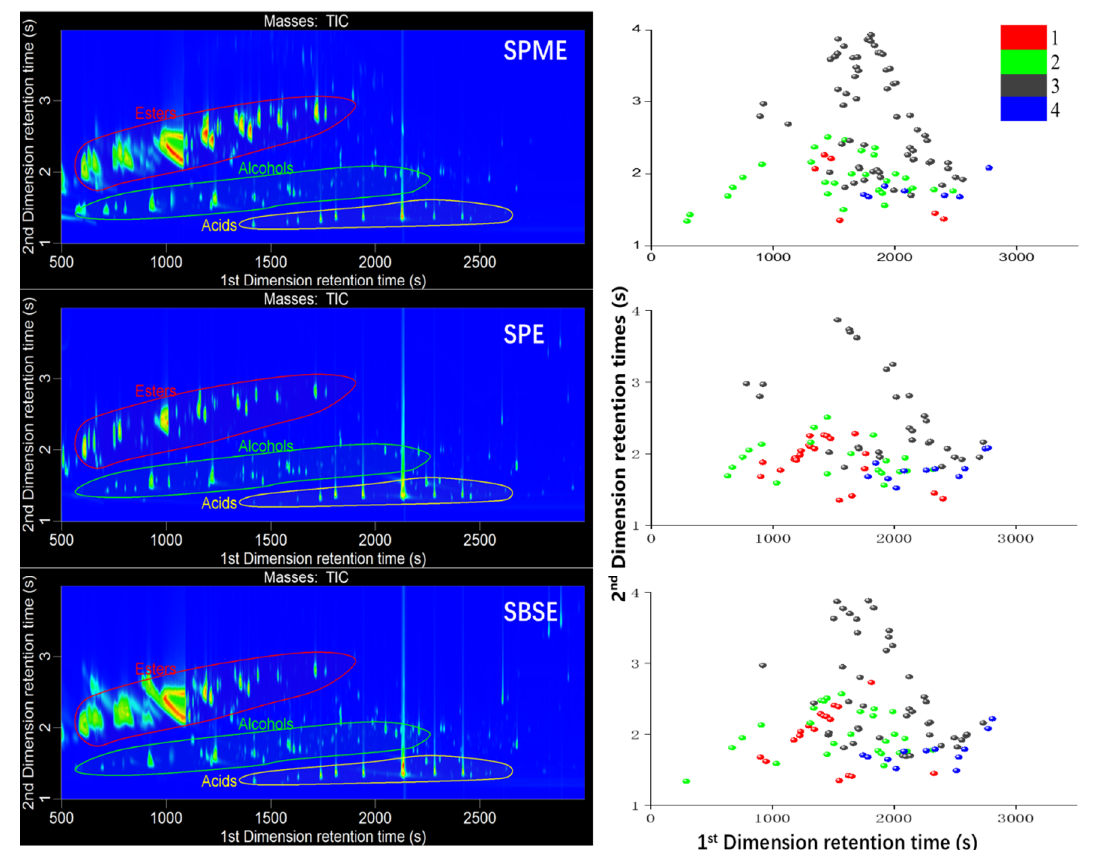
Figure 3. Total ion chromatogram (TIC) contour plot obtained from the HS-SPME-GC×GC-TOFMS, SPE-GC×GC-TOFMS, and SBSE-GC×GC-TOFMS analysis of herbaceous aroma-type Baijiu, and 4 classes of compounds distributed in contour plot (red balls are nitrogenous compounds, green balls are sulfides, gray balls are terpenes, and blue balls are lactone compounds).